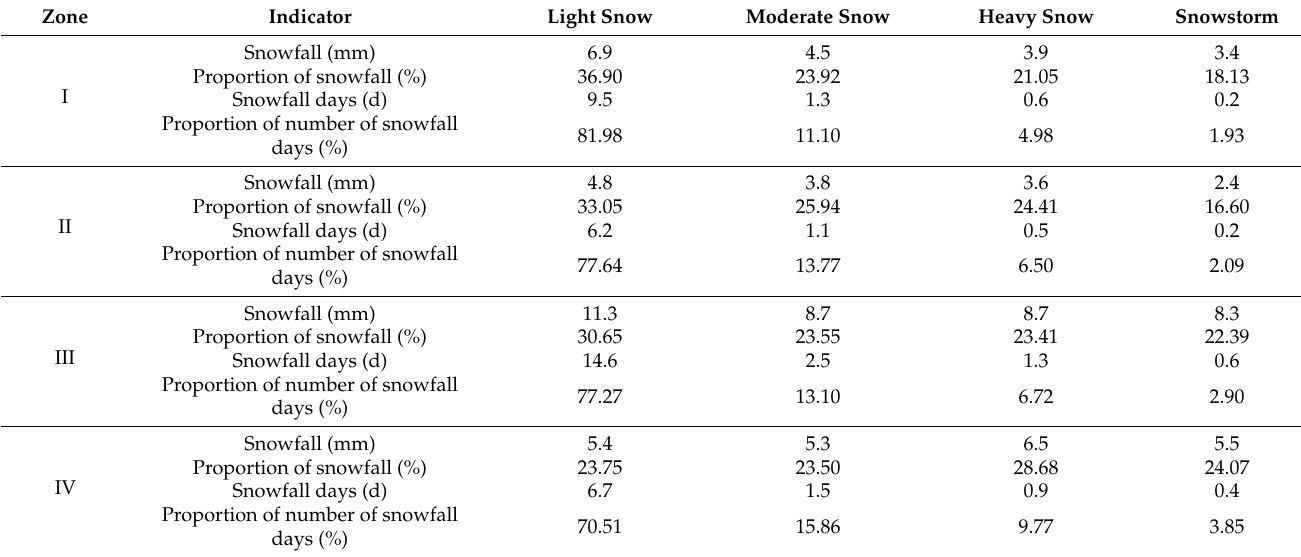
Table 4. Statistic of different levels of annual average snowfall and snowfall days in each zone. Zone Indicator Light Snow Moderate Snow Heavy Snow